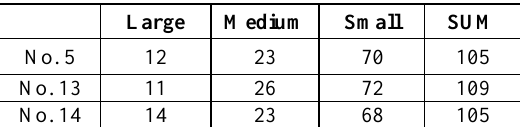
Table 4. Results of the algorithm for the impact craters detection proceed on a test dataset with the structures type indication (large, medium, small) Additionally, counting of crater’s markers takes place only inside randomly selected cells over the analysed area. These data will enable the perform the comparative analysis between the automatically obtained results and the reference dataset.